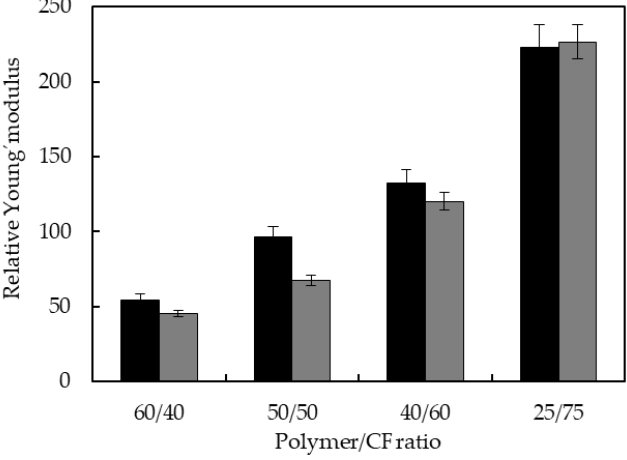
Figure 8. Relative Young’s modulus of TPUU-SS/CF (black) and TPUU/CF (gray) biocomposites.